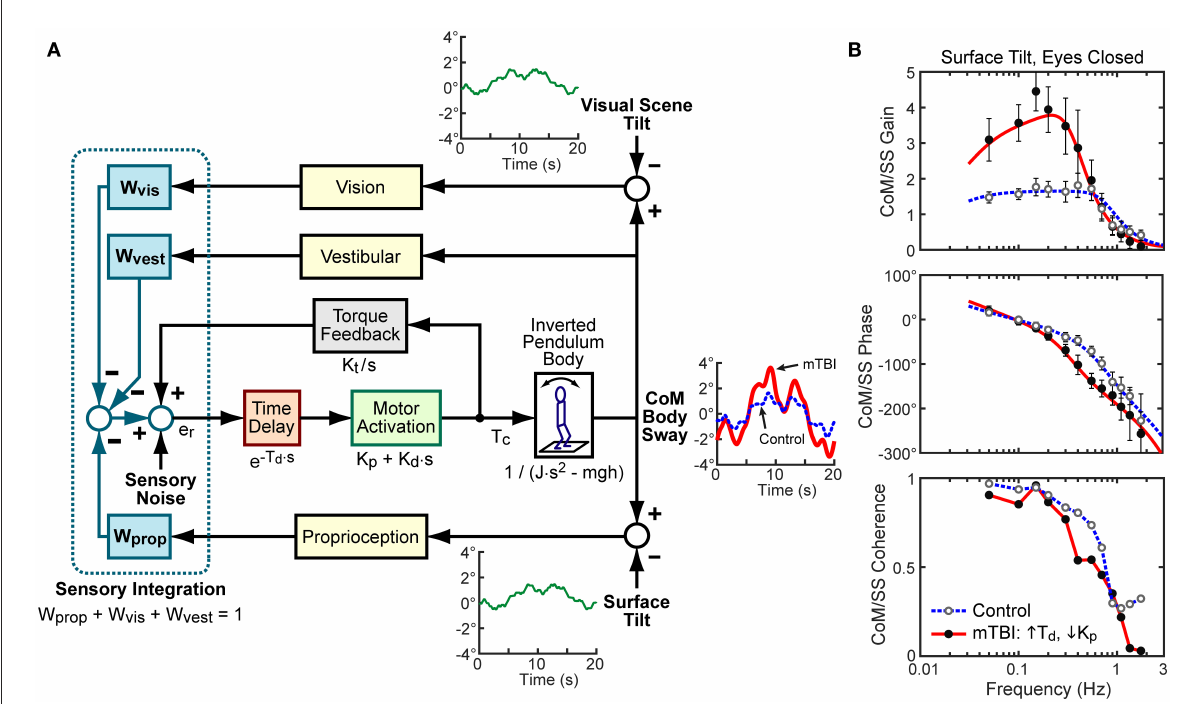
FIGURE1 (A) Block diagram of Central Sensorimotor Integration (CSMI) feedback control model of the balance system used to identify functionally relevant balance control parameters of individual subjects. External stimuli, that include toe-up/toe-down rotational tilts of the stance surface and/or forward/backward tilts of the visual scene, evoke anterior-posterior (AP) body center-of-mass (CoM) sway responses represented by angular changes with respect to an upright vertical orientation of a body represented as an inverted pendulum. An internal “Sensory Noise” source is assumed to account for the observed variability of CoM sway. Example cycle-average stimulus-evoked sways are shown from two subjects from an eyes-closed, surface-tilt trial. The control subject’s average sway (thin blue dotted line) was close to the average across all control subjects. The mTBI subject (thick red line) was from a subset of mTBI subjects with identified CSMI parameters with particularly long time delays, T d , and low motor activation stiffness, K p , values. (B) Examples of frequency domain analyses that calculated the control and mTBI subjects experimental Frequency Response Function (FRF) expressed as gain (ratio of CoM response amplitude to stimulus amplitude) and phase (normalized timing of response relative to the stimulus) as a function of stimulus frequency. The frequency domain analyses also provided Coherence Functions that characterized the signal-to-noise characteristics of the stimulus-response data with higher coherence values indicating better signal-to-noise. The experimental FRFs for the two example subjects are shown as filled (mTBI) or open (control) points with 95% confidence error bars. The solid and dashed lines in the gain and phase plots show the model-predicted FRFs after model parameters (time delay, T d , stiffness, K p , damping, K d , torque feedback, K t , and sensory weights, W ’s) were optimally adjusted to account for the experimental